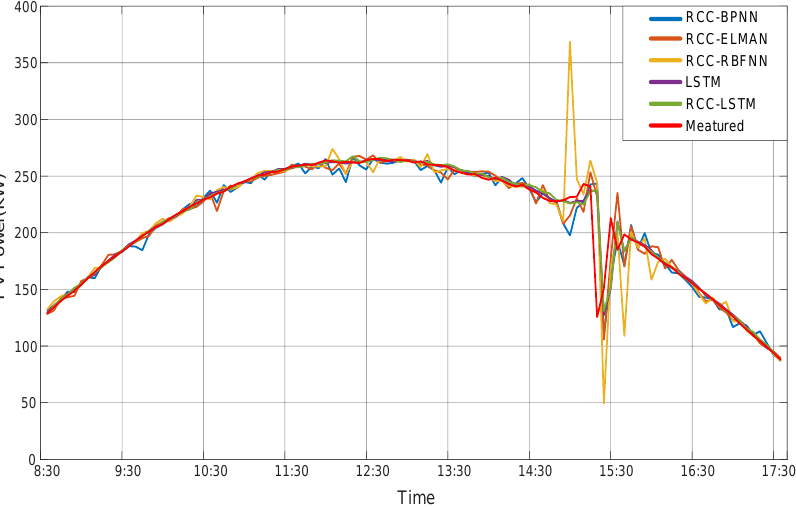
ff erent models for random days in SITE Figure 10. Forecasting result curve by different models for random days in SITE 4. Figure 10. Forecasting result curve by di